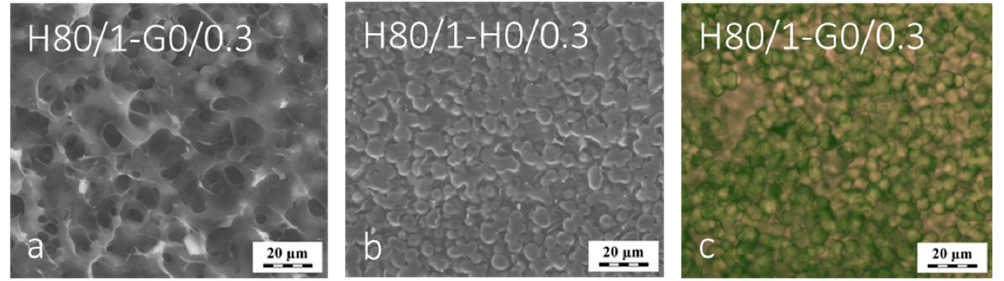
Scheme 2. Distribution of the first and second macromolecular networks in interpenetrating network (IPN) hydrogels prepared by sequential polymerization presented schematically. The produced homogeneously interpenetrated networks based on G40/3 and H0/1 and microstructured IPNs based on H80/1.